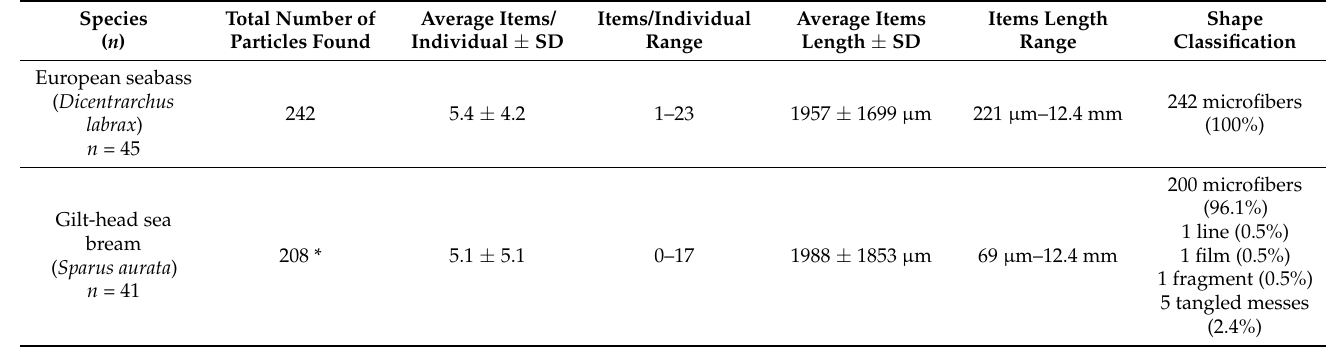
Table 2. Results of the analysis of the gastrointestinal tracts of Dicentrarchus labrax and Sparus aurata fishes bought in local markets of Tenerife (Canary Islands, Spain) and reared in aquaculture systems in the southwest of the